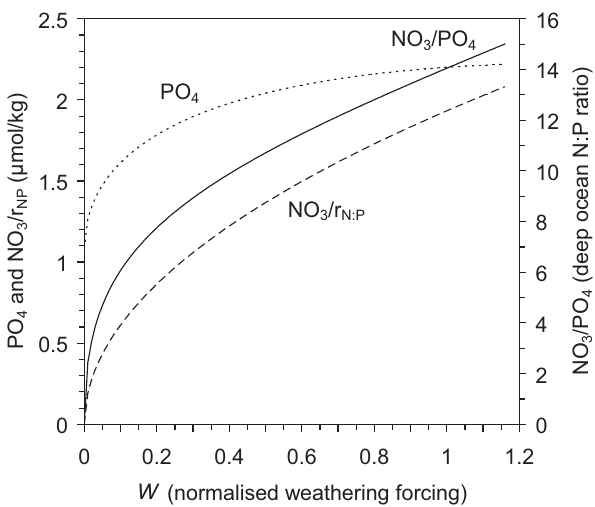
Fig. 8. Analytic solutions for the dependence of steady state PO 4 (dotted line), NO 3 / r N : P (dashed line), and deep ocean N:P ratio (solid line) on weathering forcing ( W ) in the LW model. Note that steady state is only achieved for W ≤ 1 .